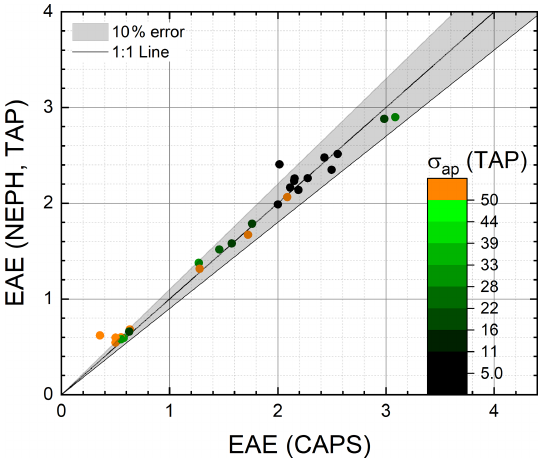
Figure 11. Scatter plot of SAE(CAPS, TAP) measurements com- pared to SAE(NEPH) measurements for AQ–AS mixtures. An error band of 10% is shown.